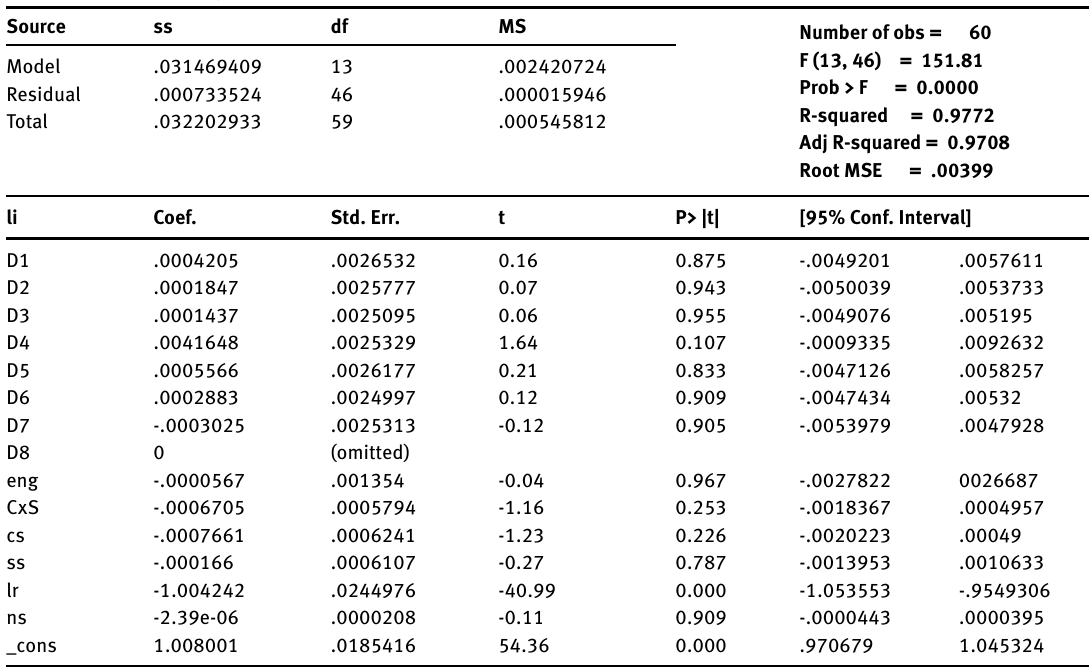
Table 3: Regression analysis